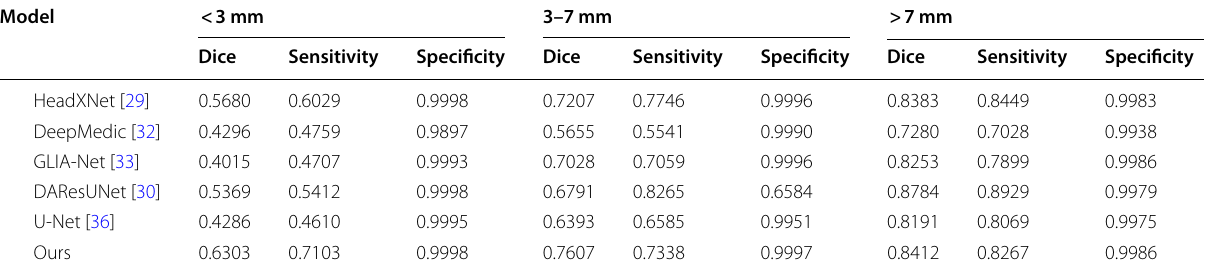
Table 6 Comparison of the segmentation performances of different methods, on the dataset of the Affiliated Hospital of Qingdao University